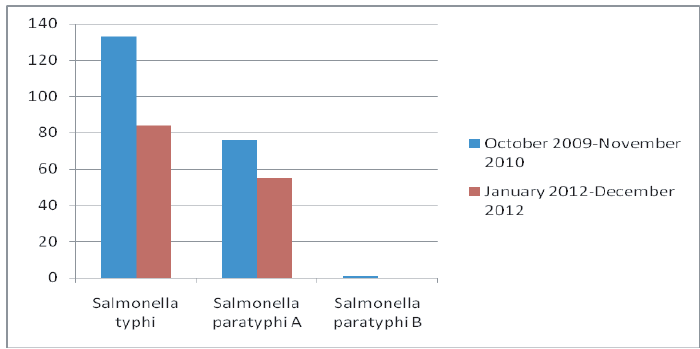
Fig 2. Distribution of isolated organisms Table I: Antimicrobial sensitivity pattern in enteric fever